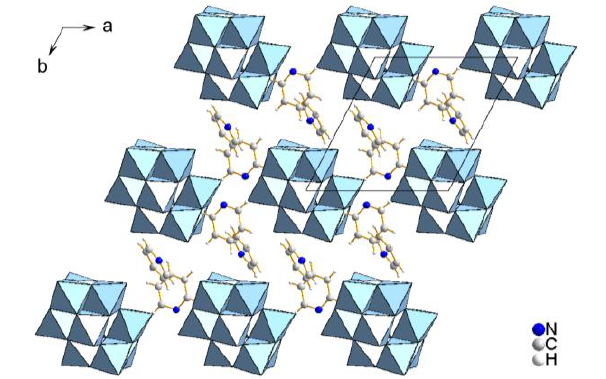
Figure 2. Molecular arrangements in the inorganic layers of C groups are omitted for clarity.